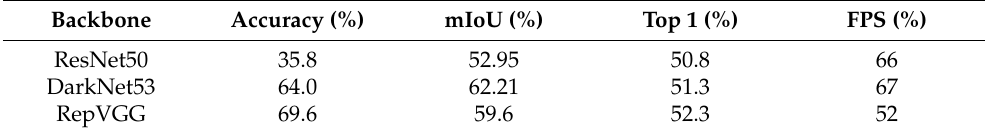
Table 7. Comparison of networks with ResNet50, DarkNet53, and RepVGG as the backbone.